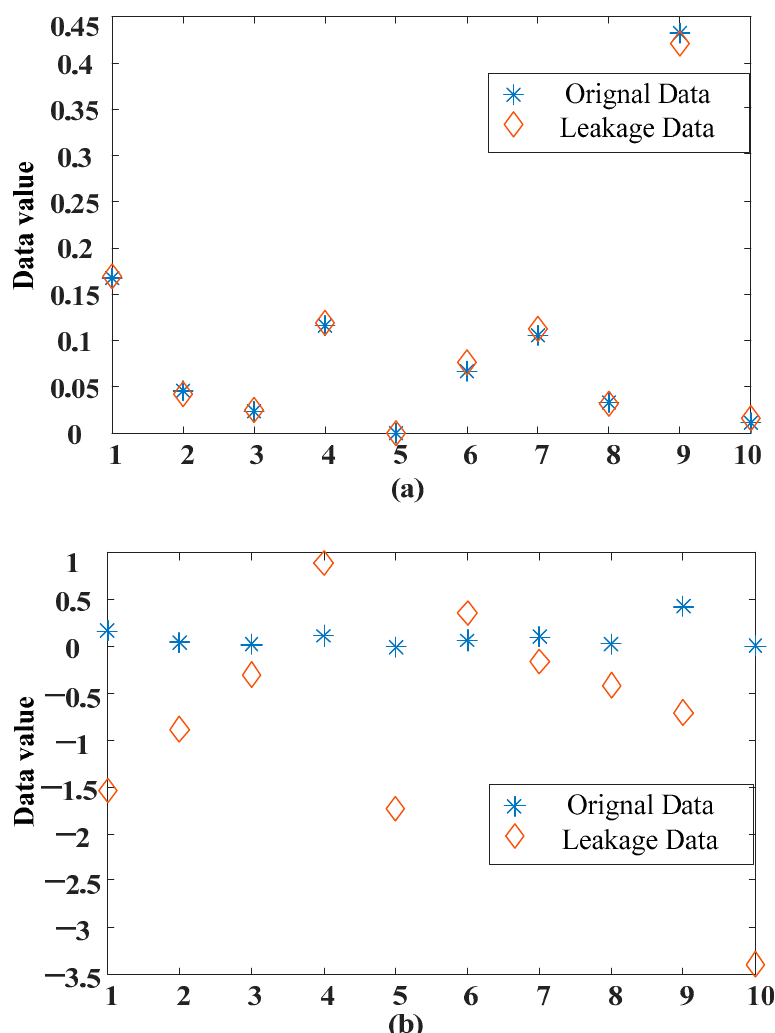
Figure 16. Client data information leakage. ( a ) Client data information leaked by the full gradient information. ( b ) Client data information leaked by the i -MFN algorithm in top sharing